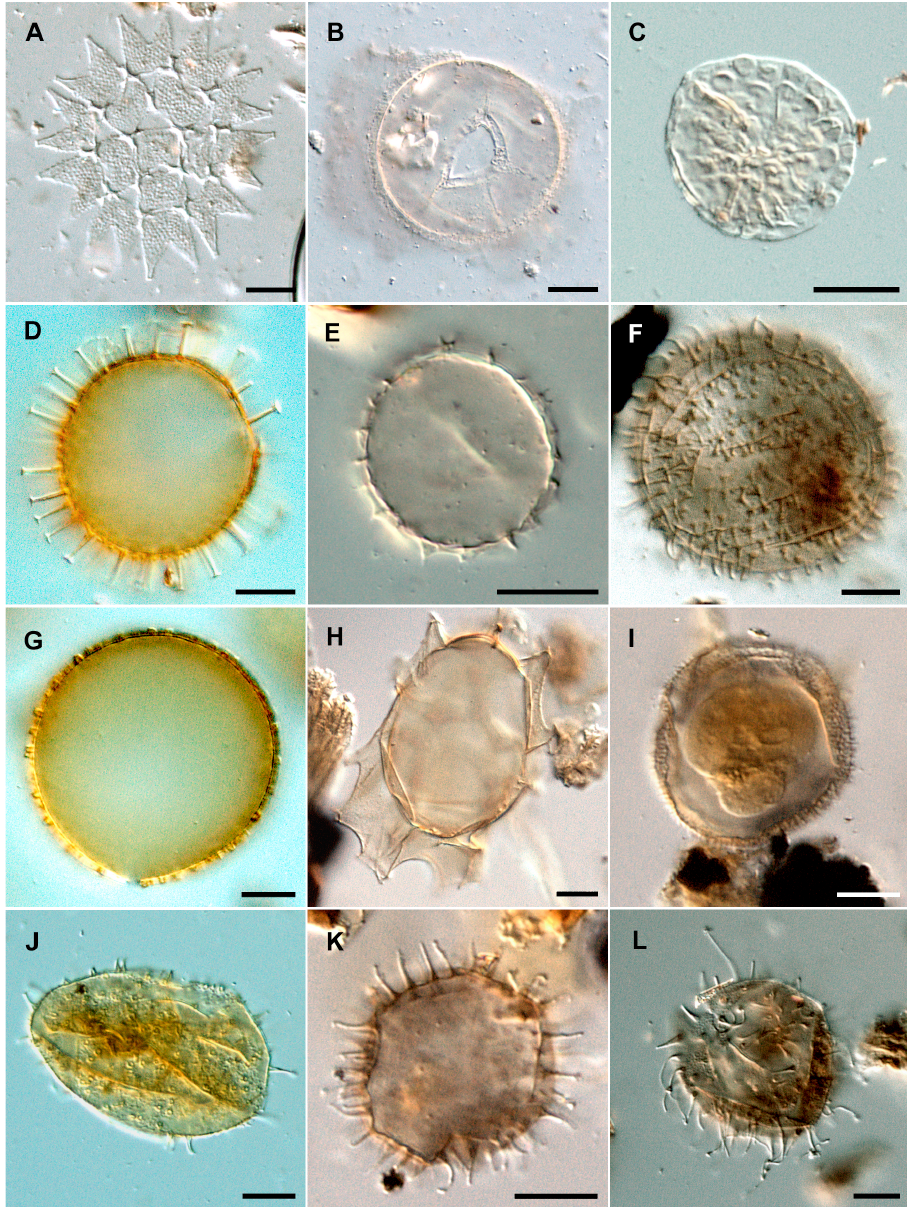
Fig. 2. The scale bar represents 10µm. A. Pediastrum sp. B. Halodinium sp. C. Zygnema sp. D. Operculodinium centrocarpum E. Cyst of Pentapharsodinium dalei F. Islandinium minutum G. Operculodinium centrocarpum short spines H. Spiniferites frigidus I. Islandinium brevispinosum J. Operculodinium centrocarpum var. Arctic K. Echinidinium karaense L. Islandinium cezare